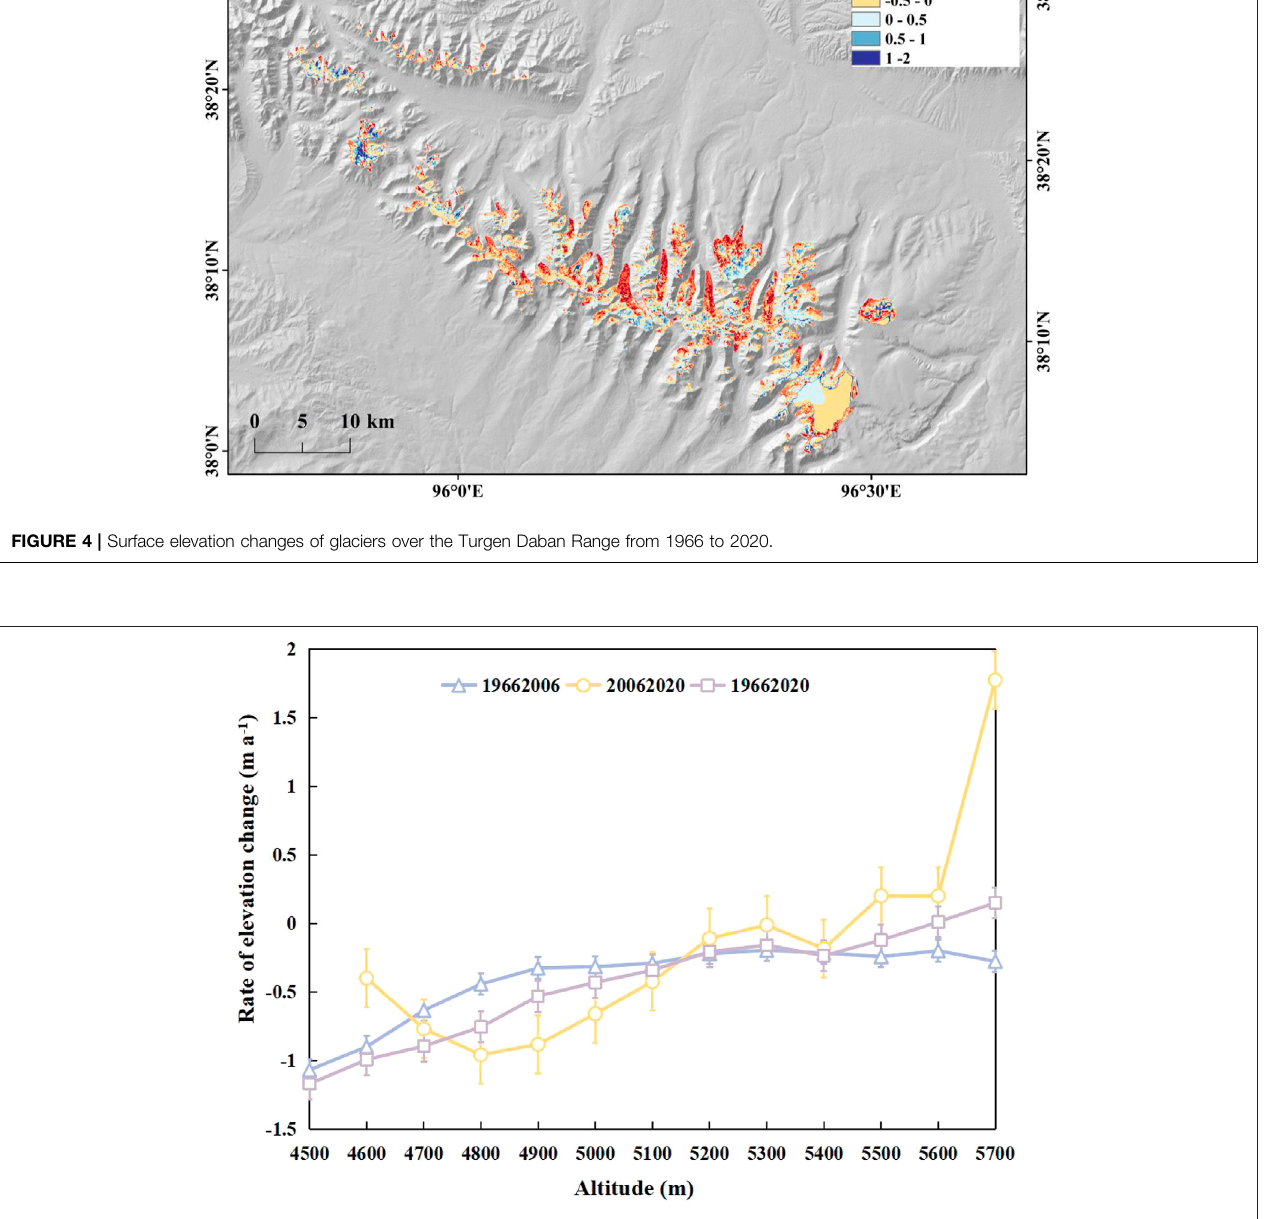
0.23 m w.e.a − 1 , respectively ( Figure 7C ). The aspects of glacier mass loss vary obviously. On the whole, the mass loss of the glacier centered on the southeast is the strongest. This distribution may be due to the strong solar radiation on the southeast slope and more precipitation on the northwest slope affected by the westerly circulation (Li 2018).